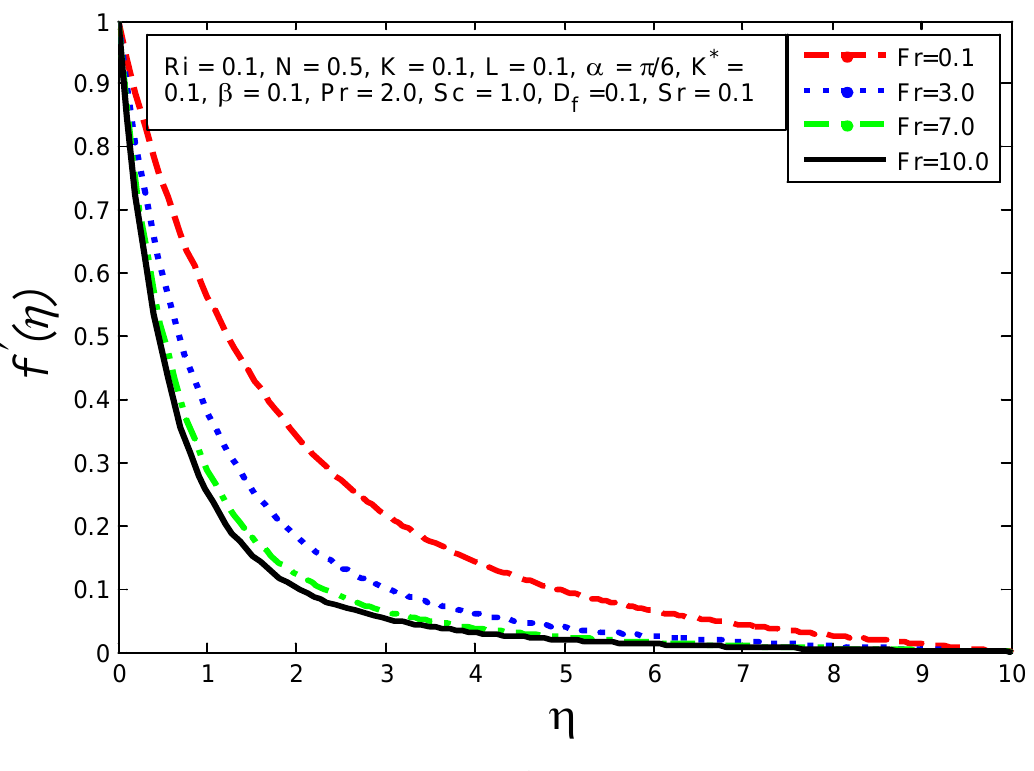
Figure 8. Consequences of Fr on f (cid:48) ( η ) .